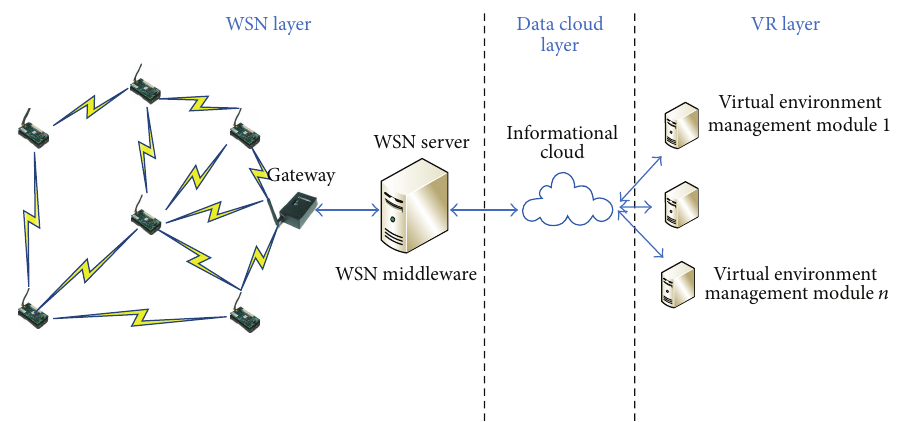
Figure 4: Generic architecture of the pervasive radio mapping